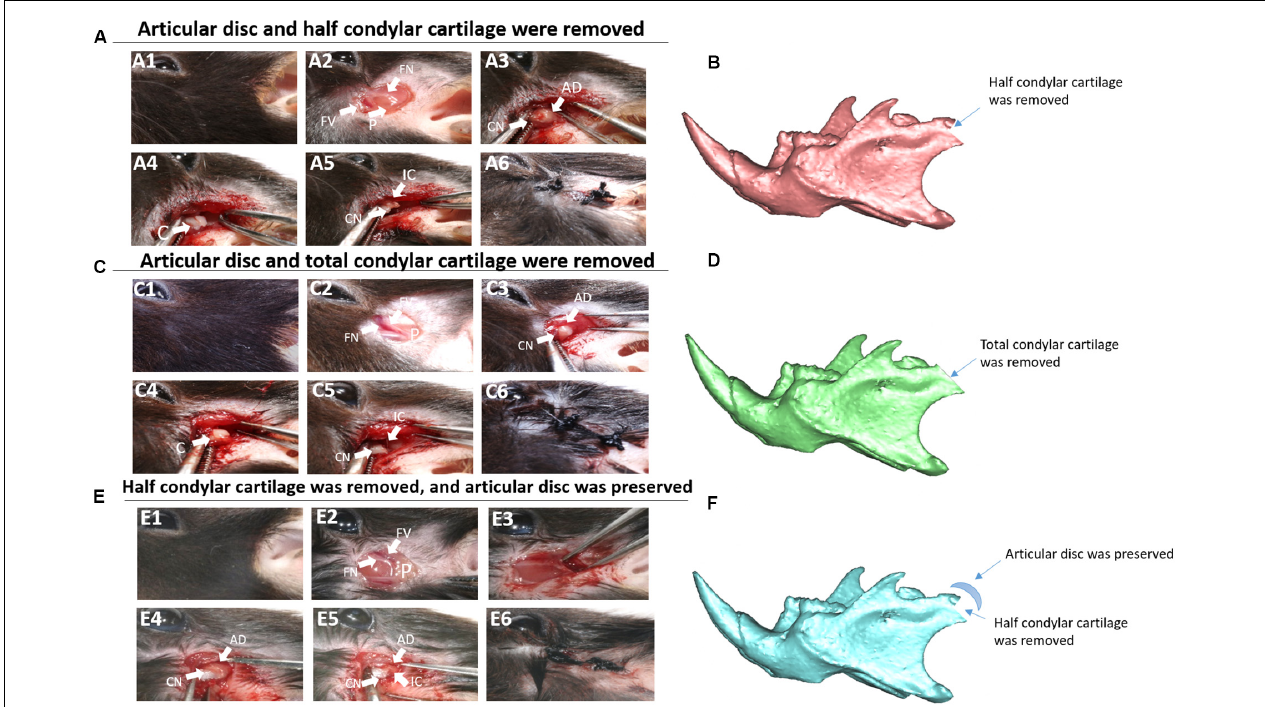
FIGURE 1 | Animal model construction. (A) The first animal model (the articular disc and half condylar cartilage were removed in mice). (A1) Surgery on the left side. (A2) The preauricular skin was cut, and the facial vessels and nerves were exposed. (A3) The muscle was cut, and the integral condyle was exposed. (A4) The articular capsule and disc were removed. (A5) The latter half of the condylar cartilage was removed using scissors. (A6) The wound was closed. (B) 3D schematic of the first animal model. (C) The second animal model (the articular disc and total condylar cartilage were removed in mice). (C1–C4,C6) show the same procedures described above. (C5) Total condylar cartilage was removed using scissors. (D) 3D schematic of the second animal model. (E) The third animal model (half condylar cartilage was removed, but the articular disc was preserved). (E1–E3,E6) show the same procedures described above. (E4) The articular disc was preserved. (E5) The latter half of the condylar cartilage was removed using scissors, ensuring that there was no evident displacement of the articular disc. (F) 3D schematic of the third animal model. AD, articular disc; C, condyle; CN, condyle neck; FN, facial nerve; FV, facial vessel; IC, injured condyle; P, parotid